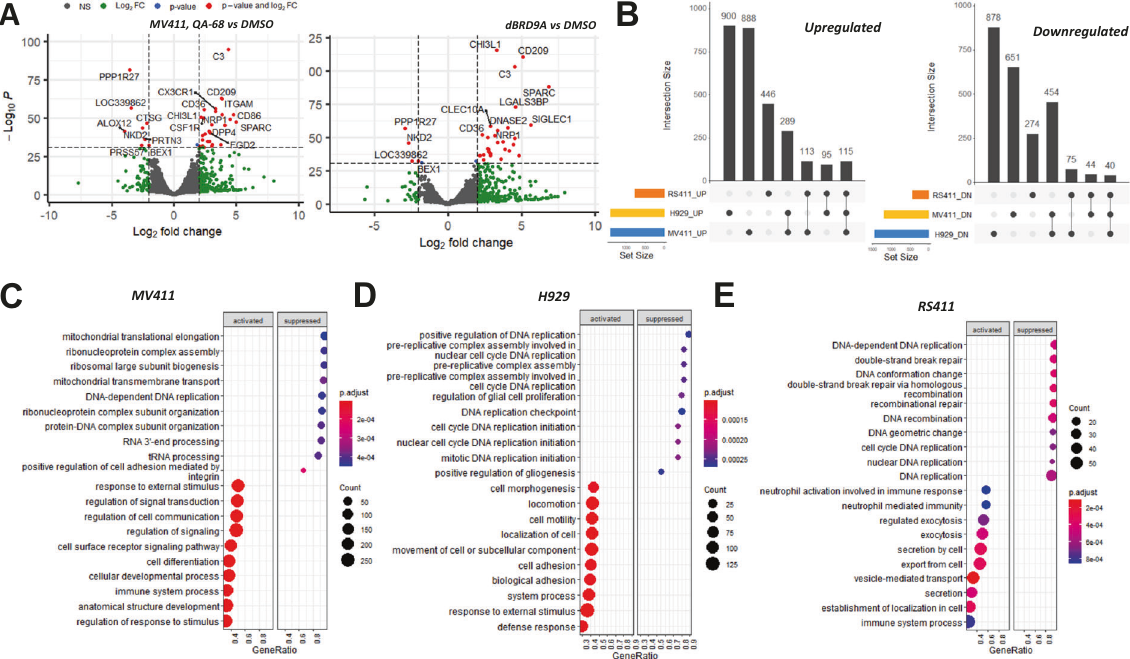
Fig. 8 Targeted loss of BRD9 leads to deregulation of major signaling pathways in hematopoietic malignancies, including cell cycle progression, the in fl ammatory response, immune response, cell adhesion and DNA replication and repair. A Global transcript perturbation pro fi le after QA-68 or dBRD9-A treatment in MV411 was contrasted. Genes undergoing |log2FC|> 2 and p<10e-32 displayed as red dots. B Intersection sets of the number of differentially expressed genes (DEGs) that are unique and conserved after QA-68 treatment in MV4-11, H929 and RS4;11 cells. ( C – E ) Gene Set Enrichment Analysis of QA-68 treatment induced DEGs in MV4-11 ( C ), H929 ( D ), and RS4;11 ( E ) cells. DEGs are de fi ned by Benjamini & Hochberg FDR<0.05 & |FC |>1.5 between QA-68 and DMSO treatments in respective cell